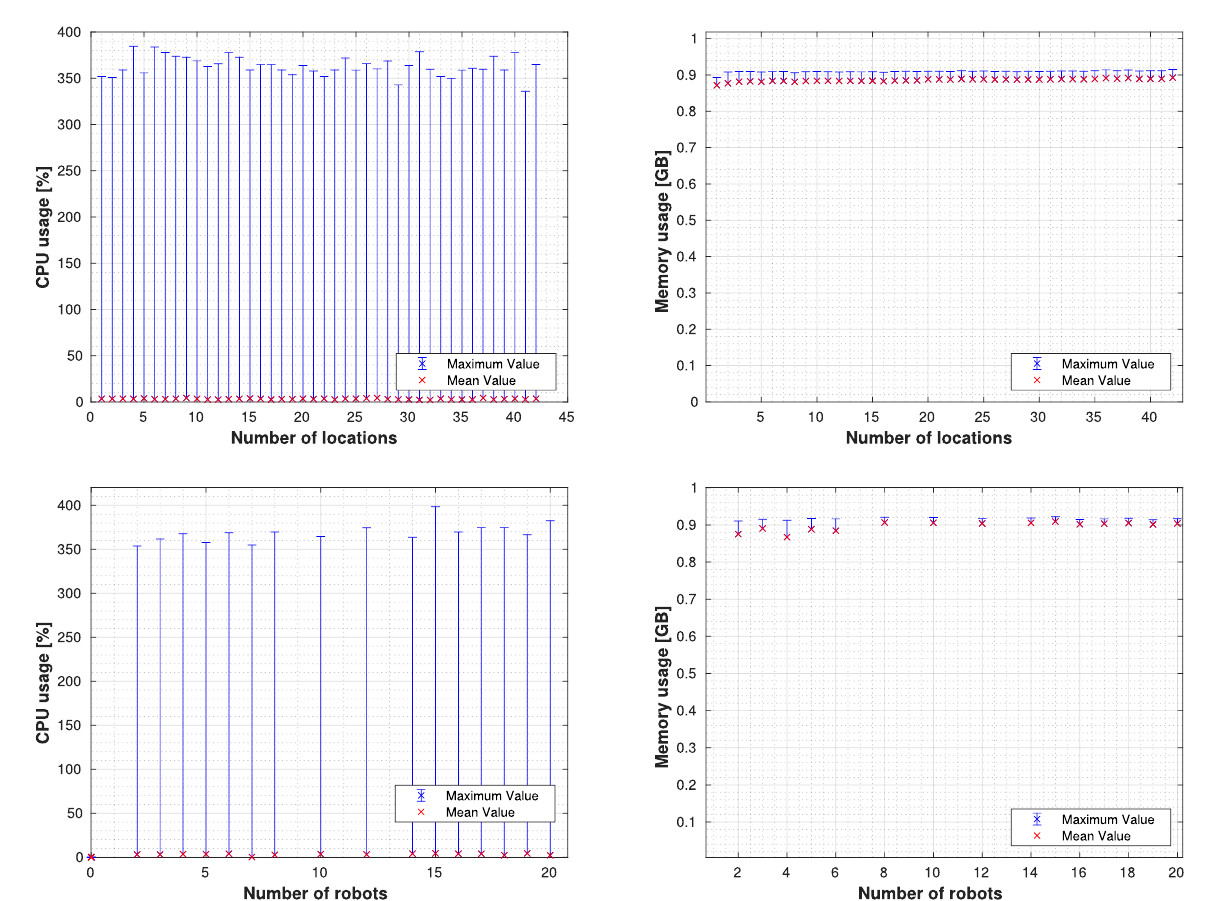
Figure 11. ( Top Left ) Execution module CPU usage as the number of locations increases; ( Top Right ) Execution module memory usage as the number of locations increases; ( Bottom Left ) Execution module CPU usage as the number of robots increases; ( Bottom Right ) Execution module memory usage as the number of robots